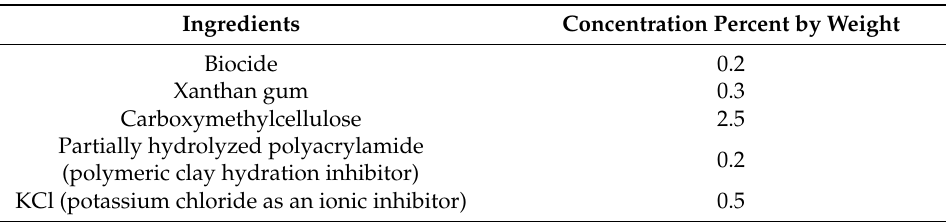
Table 1. Composition of the drilling mud.